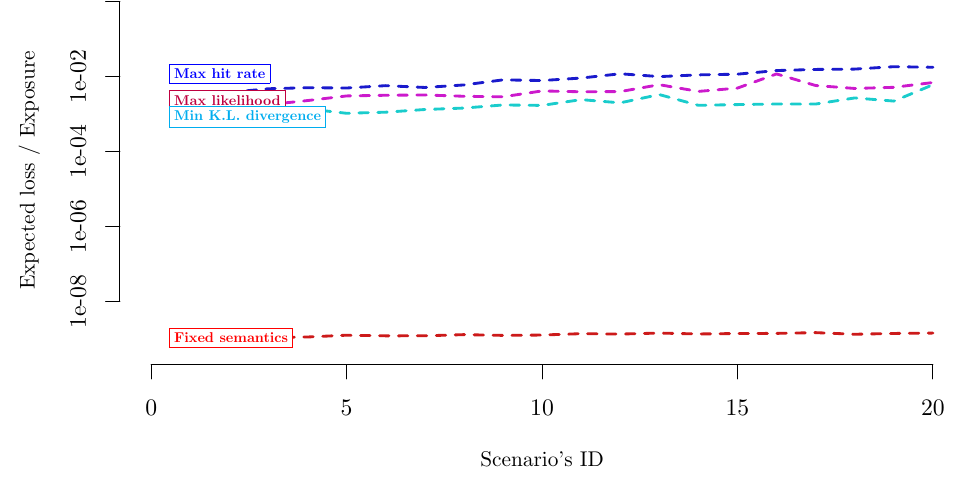
Figure 5. Exposure obtained across the considered scenarios, by applying the decisional system described in (21) and each of the criteria introduced in Sections 2.2.1–2.2.4.